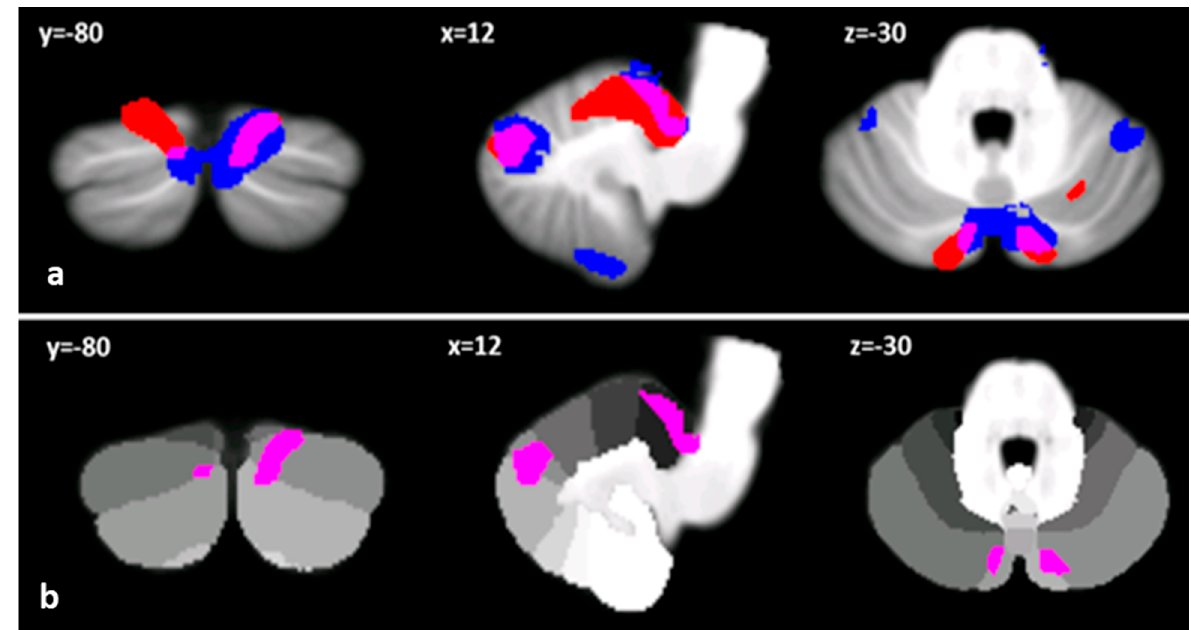
Figure 1. Cerebellar regions showing patterns of significantly reduced cerebellar grey matter (GM) are reported and su- perimposed on the spatially unbiased infratentorial template (SUIT) [51] in coronal (y), axial (z) and sagittal (x) sections. ( a ) BD < HS (in blue); ( b ) CD < HS (in red); ( c ) CD < BD (in green). The results are considered significant at p -values < 0.05 FWE corrected at the cluster level. Images are shown in the radiological convention.